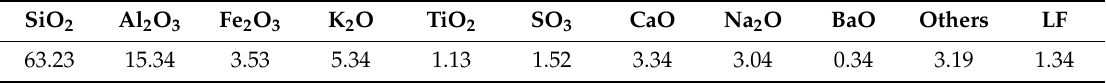
Table 2. Chemical composition of the granite residue (%).